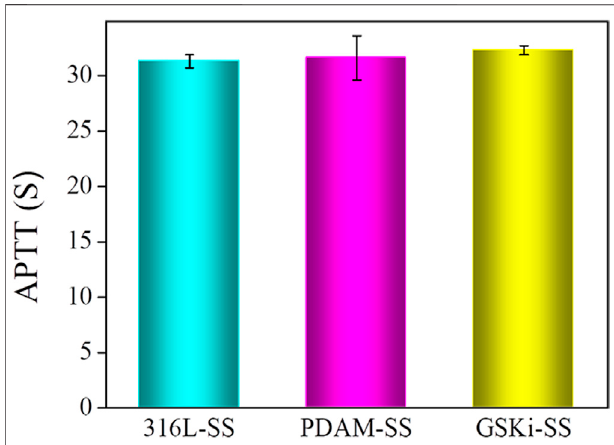
FIGURE 4 | APTT evaluation of 316L-SS, PDAM-SS and GSKi-SS (mean ± SD, N (cid:1)